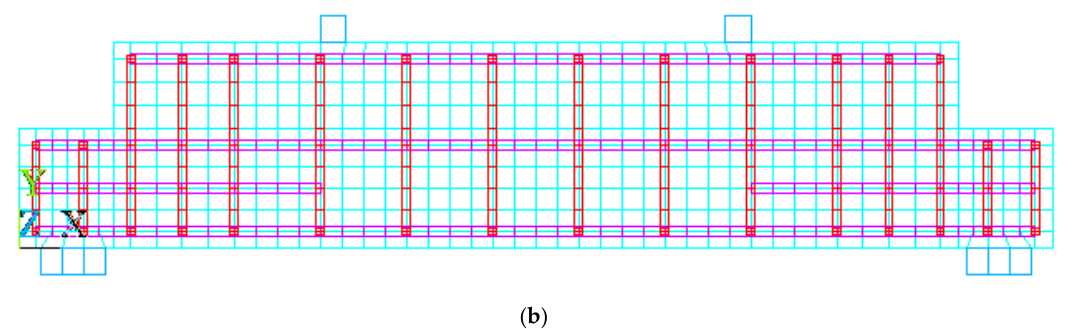
Figure 3. Experimental details and numerical simulations of models DENT1 and DENT2. ( a ) Geometry layout in the previous experimental investigation [39]. ( b ) Numerical modelling.